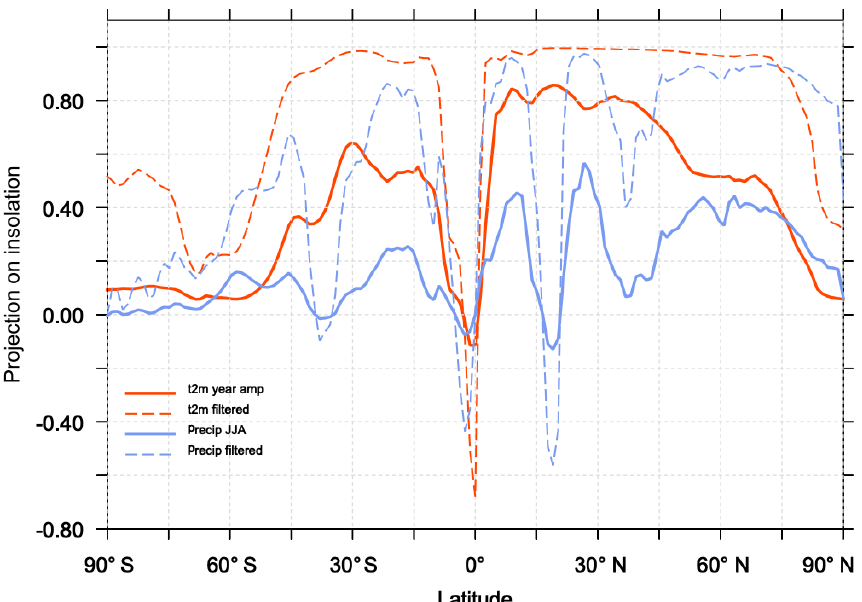
Figure 7. Fraction of the evolution of the seasonal amplitude of temperature (red) and precipitation (blue) represented by the projection of these climate variables on the evolution of the seasonal amplitude of insolation as a function of latitude. The solid line stands for the raw signal and the dotted line for the signal after a 100-year